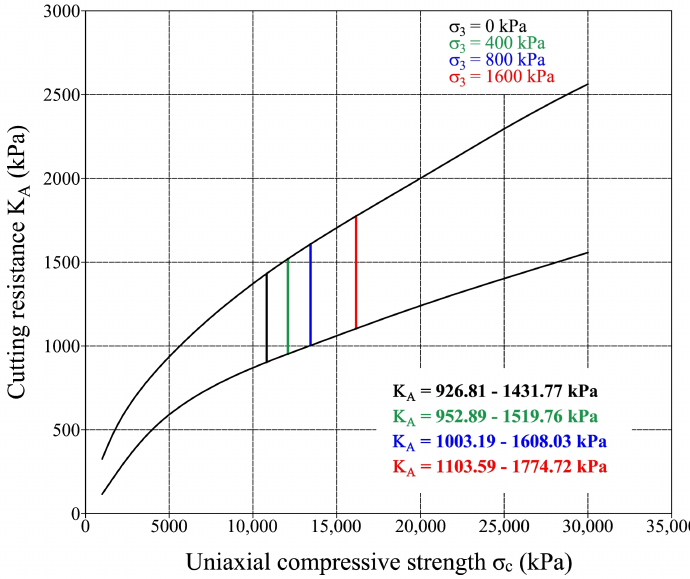
Minerals 2021 , 11 , x FOR PEER REVIEW 15 of 18